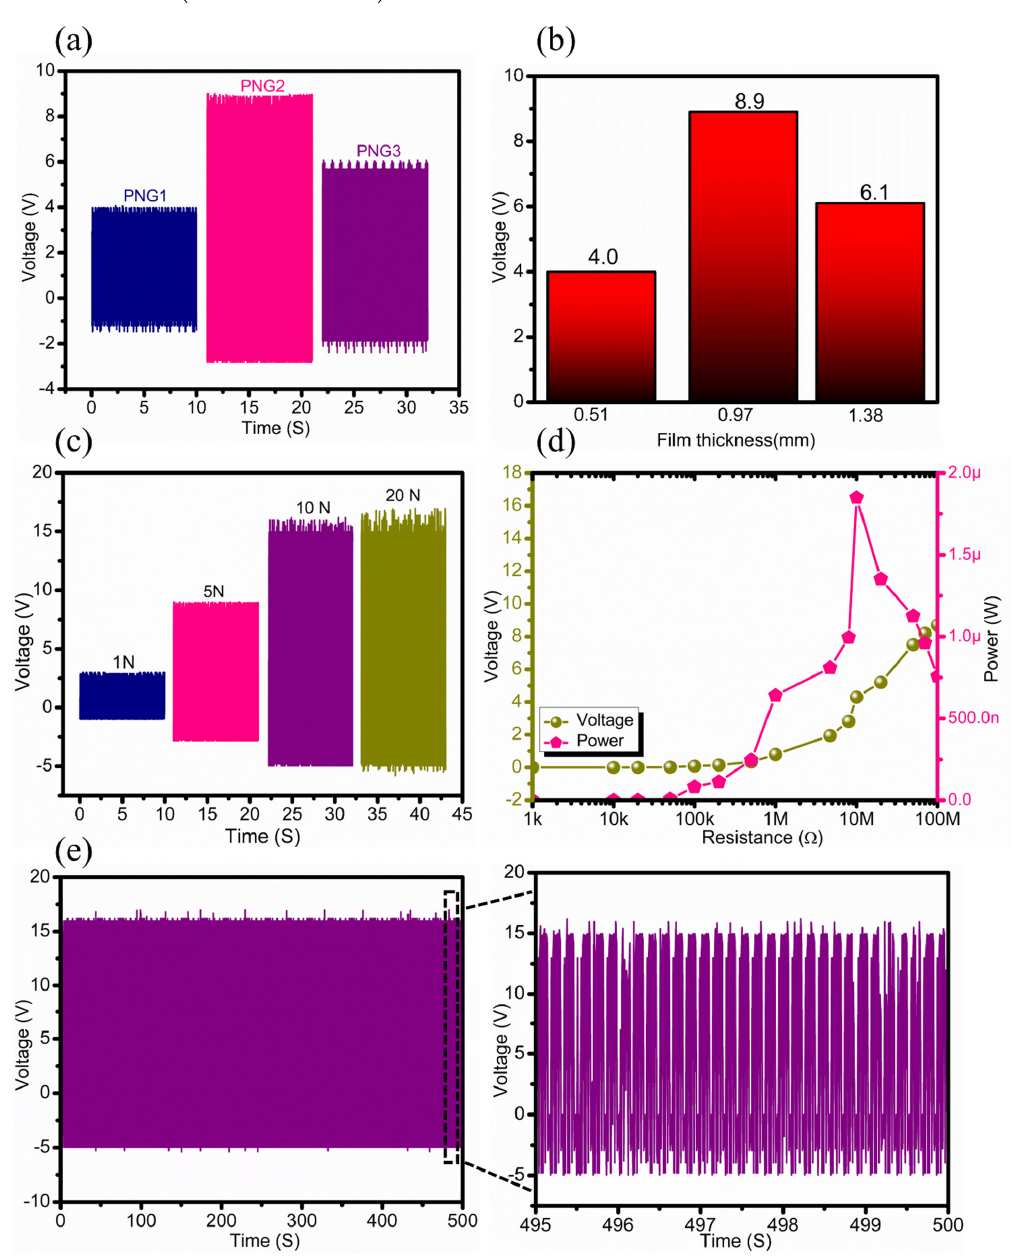
Figure 5. ( a ) Electrical response of PNG devices (PNG1, PNG2, PNG3) under a mechanical force of 5 N; ( b ) film thickness of CS-PVDF-based piezoelectric film and its corresponding output performance; ( c ) voltage response of the optimized PNG2 device when different mechanical forces were applied ranging from 1 N to 20 N; ( d ) output power of the PNG2 device at different load resistances; ( e ) stability test for a period of 500 s at 10 N force and surface morphology of piezoelectric